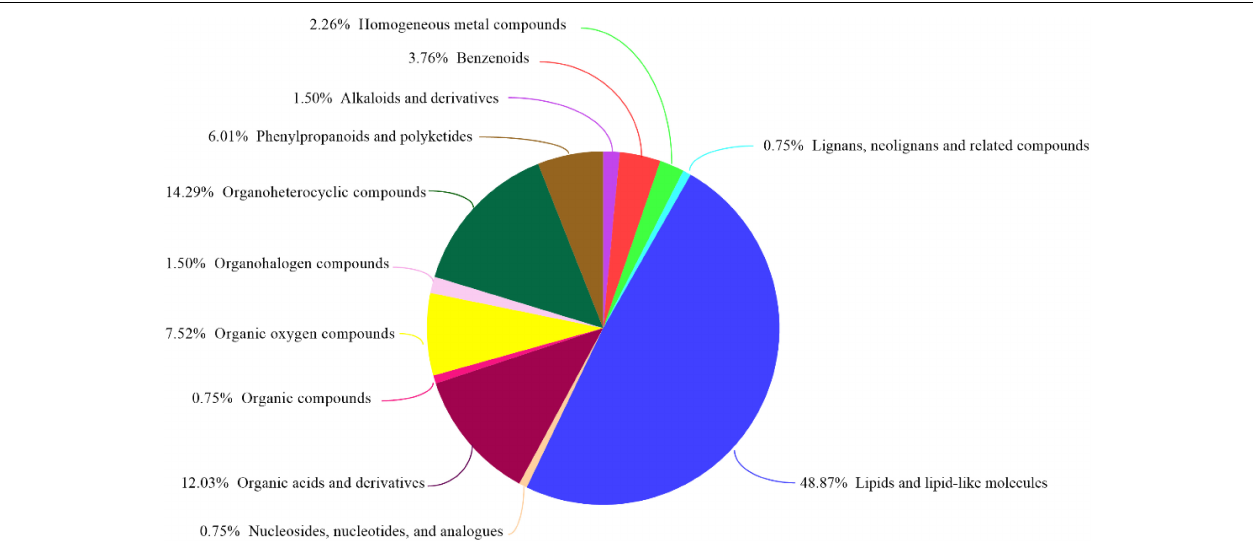
FIGURE 4 | HMDB compound classification. Based on the number of metabolites, the Human Metabolome Database (HMDB) level (Superclass, Class, or Subclass) classification and metabolite percentages are displayed. The different colors in each pie chart in the figure represent different HMDB classifications, and their area represents the relative proportion of metabolites in the classification. TABLE 2 | Metabolomic changes in the plasma in the CON, DSS and DSS- L. pentosus .